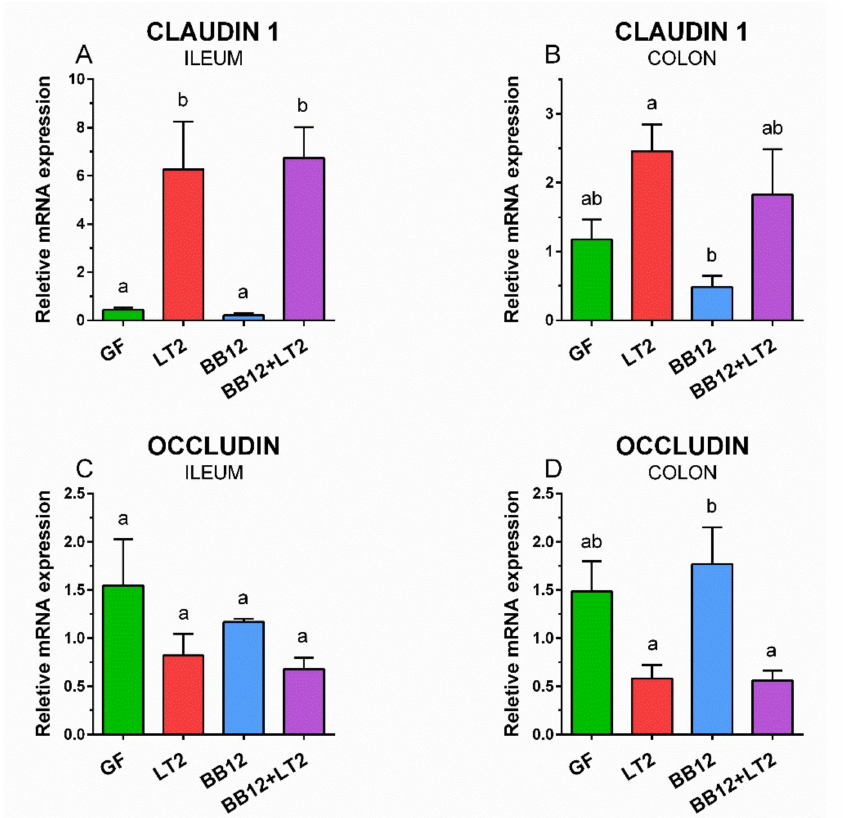
Figure 5. Relative expression (fold change) of claudin-1 ( A , B ) and occludin ( C , D ) mRNA in the ileum ( A , C ) and colon ( B , D ) of the gnotobiotic piglets: germ-free (GF), infected with S . Typhimurium LT2 for 24 h (LT2), associated with B. animalis subsp. lactis BB-12 (BB12), and associated with BB12 and infected with LT2 for 24 h (BB12 + LT2). The values are presented as mean + SEM. Statistical differences were calculated by one-way ANOVA with Tukey’s multiple comparison post hoc test, and p -values < 0.05 are denoted with different letters above the columns. Six samples in each group were